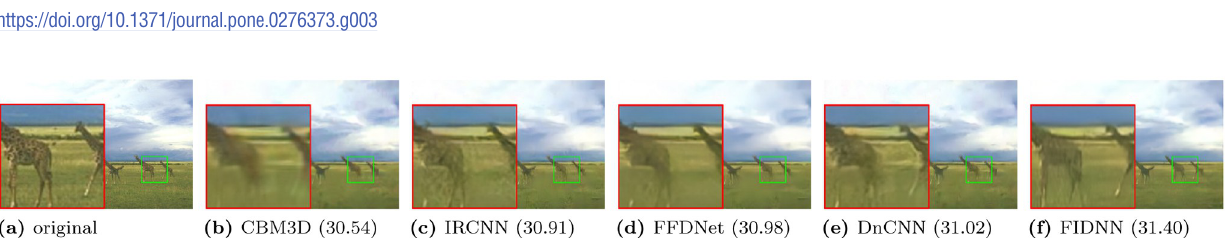
Fig 4. Color image denoising results for noise level 50 on ‘253055’ image from CBSD68 dataset. (a) original. (b) CBM3D (30.54). (c) IRCNN (30.91). (d) FFDNet (30.98). (e) DnCNN (31.02). (f) FIDNN (31.40).